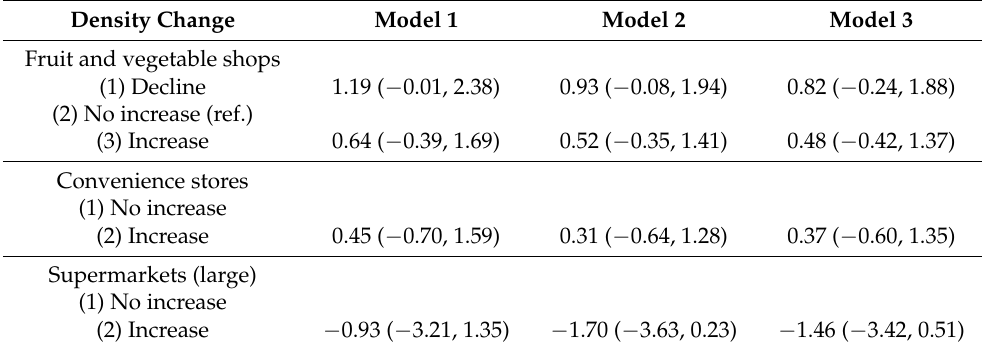
Table 4. Multilevel linear regression models of neighborhood-level density changes of food store type and diastolic blood pressure (DBP) measures for total sample ( n =